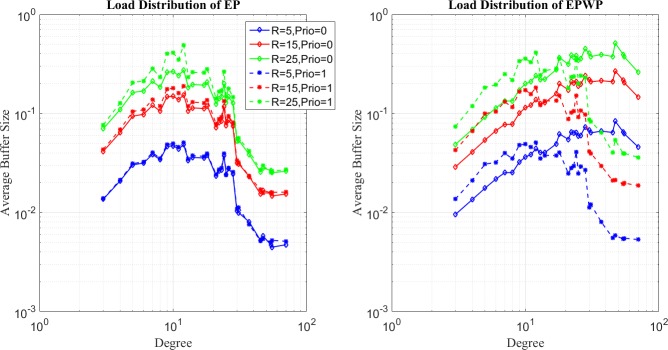
Relationship between average buffer size of two strategies and node degree for EP (left figure) and EPWP with β1 = 0.5 (right figure) on networks with 1000 nodes.